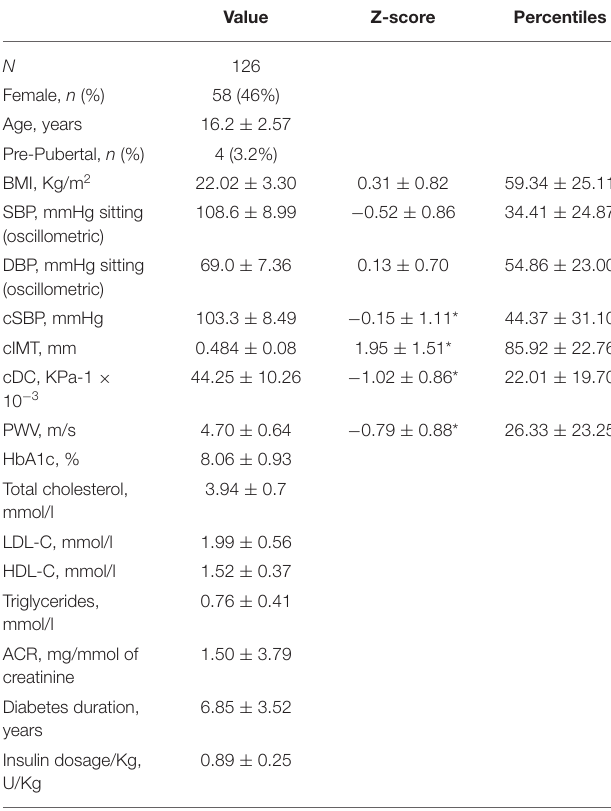
TABLE 1 | Characteristics of the 126 T1DM children and